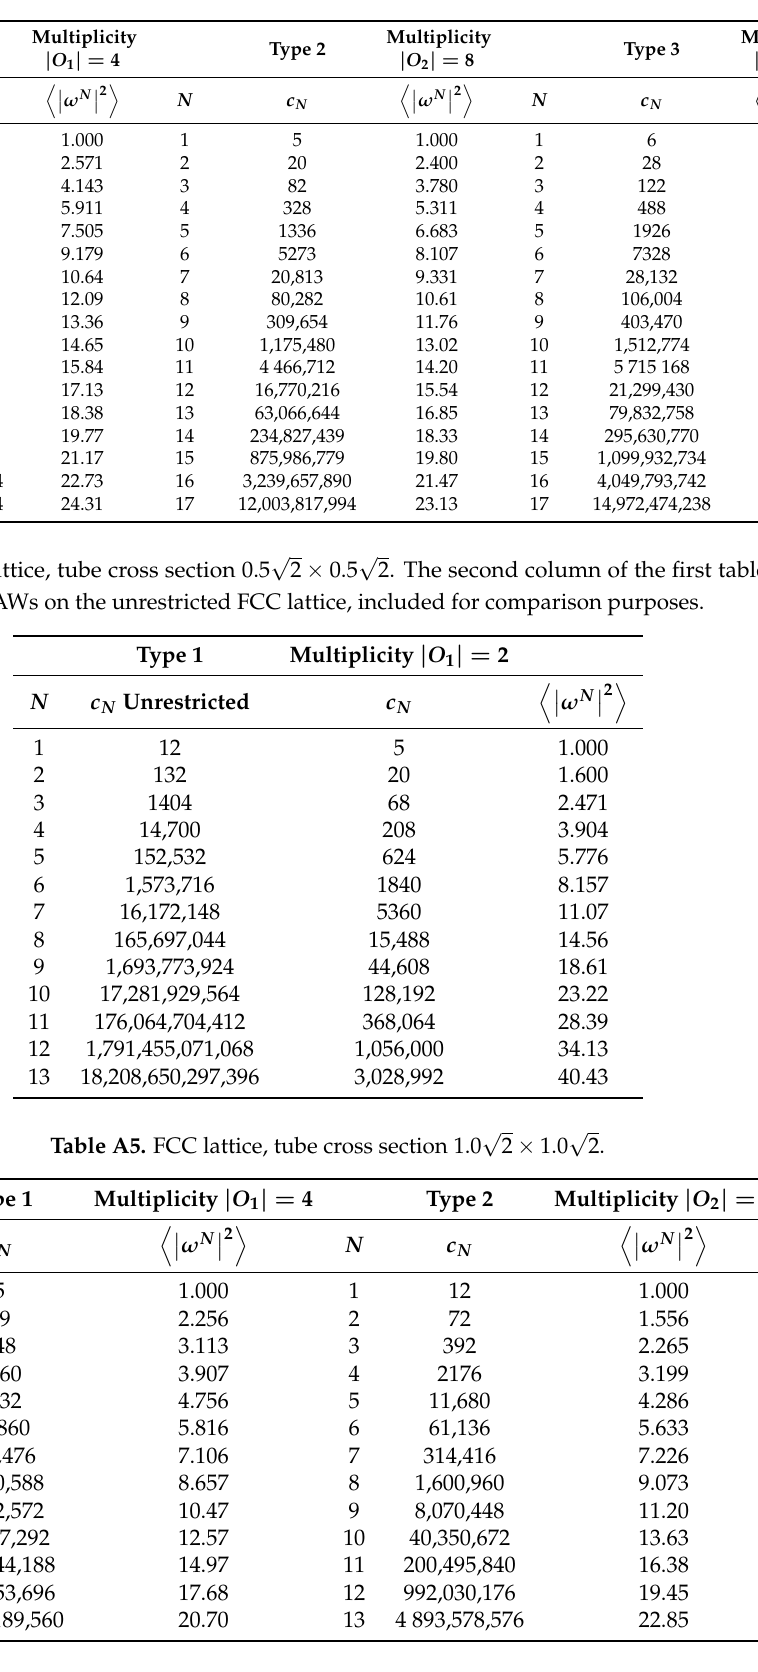
Table A3. SC lattice, tube cross section 3.0 × 3.0.